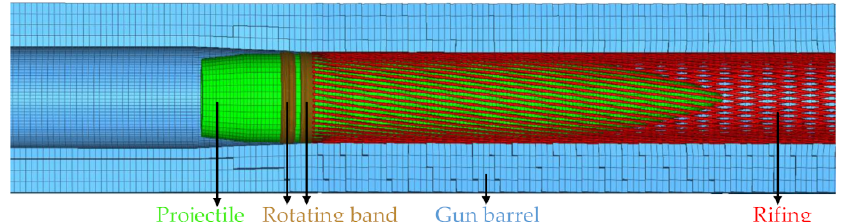
Figure 11. Three-dimensional finite element model of the gun engraving system.